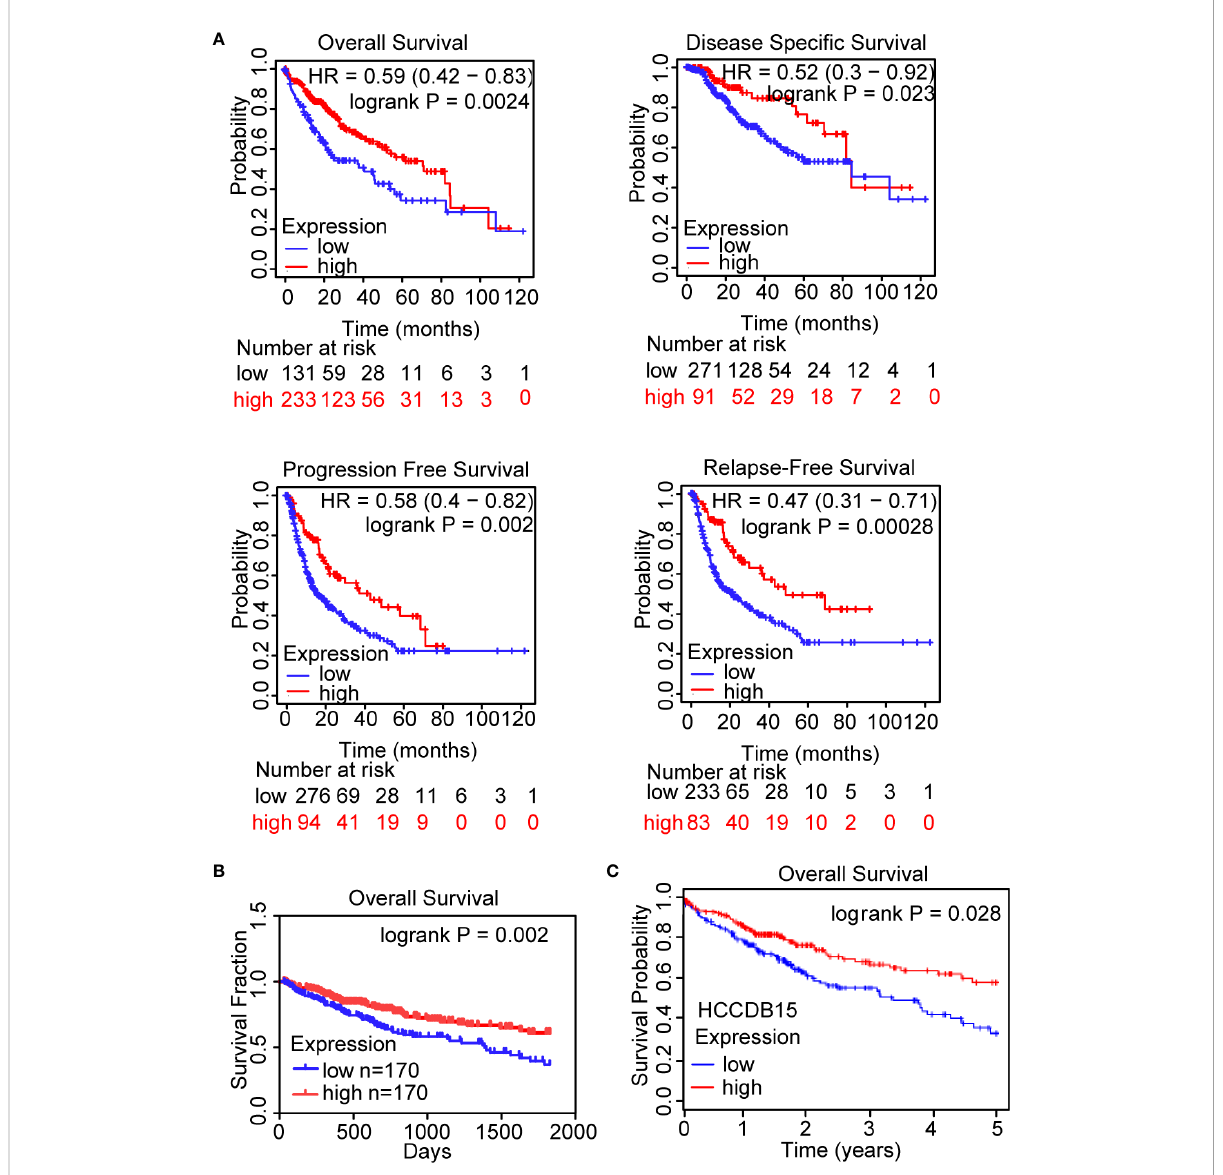
FIGURE 2 OIT3 expression was positively associated with the prognosis of HCC patients. (A – C) The clinical outcomes were markedly decreased in HCC patients with low OIT3 expression according to the Kaplan-Meier plotter database (A) , Linkedomics database (B) , and HCCDB database (C) . HR, hazard